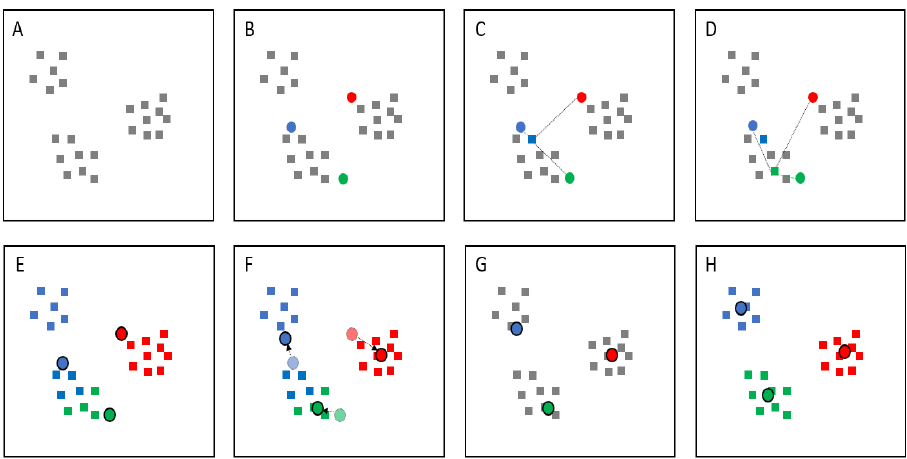
Figure 2. Demonstration of the K-means clustering algorithm, k = 3. ( A ) Data plot. ( B ) Three centroids are randomly created, and ( C ) the distance from each data-point to the centroids is calculated using Euclidean distance. ( D ) The step is repeated for all data-points, ( E ) each of which is classified into a group according to its closest centroid. ( F ) The centroid is updated to the new location based on the mean value of all data-points in the group. ( G ) The distance between each data-point and the new centroids is calculated again. ( H ) These steps are repeated until the mean value of all data-points stops changing.